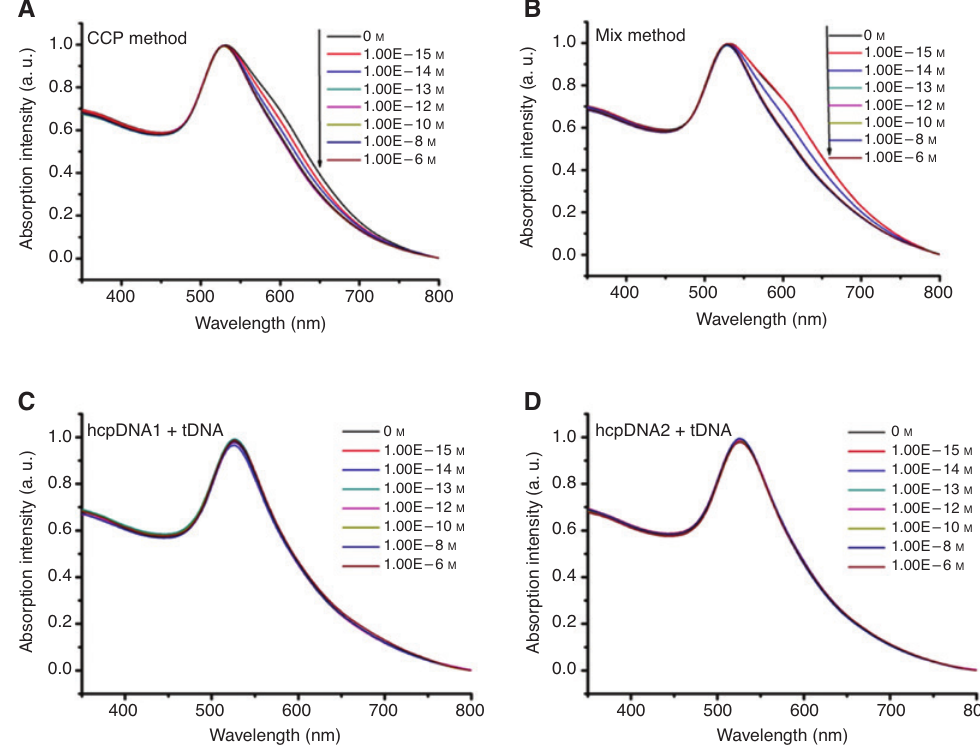
Figure 3: Two methods for tDNA detection. The UV-Visible absorbance spectra of (A) ccpDNA-PEG-AuNPs and (B) the mixtures of hcpDNA-PEG-AuNPs for different concentrations of tDNA (0, 1 fm, 10 fm, 100 fm, 1 pm, 100 pm, 10 nm and 1 um). The arrow indicates the decrease of the shoulder intensity with the increase of the tDNA concentrations. The UV-Visible absorbance spectra of hcpDNA1-PEG-AuNP (C) and hcpDNA2-PEG-AuNP (D) solutions for different concentrations of tDNA (0, 1 fm, 10 fm, 100 fm, 1 pm, 100 pm, 10 nm and 1